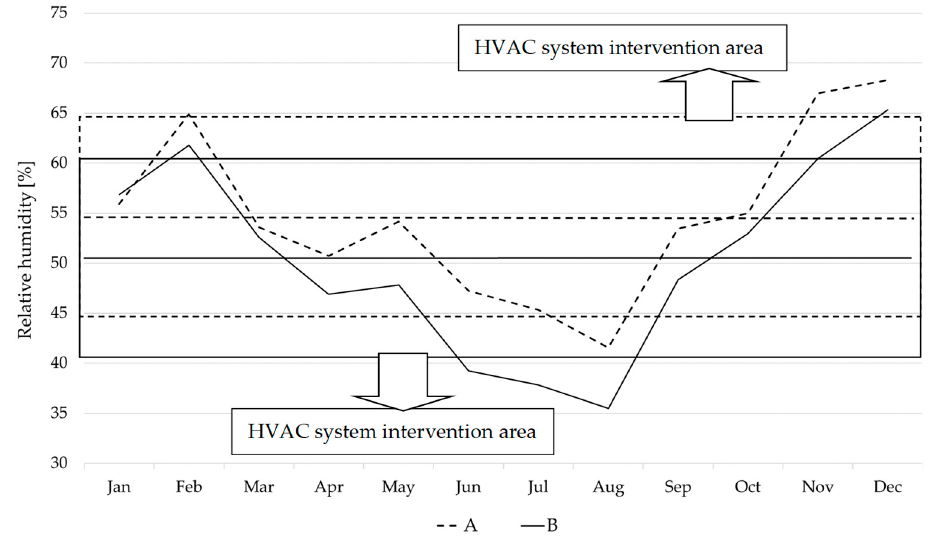
Figure 12. Trend of monthly and annual (horizontal line) mean values of RH for Lungarno ( A ) and Ponte Vecchio ( B ). The rectangles define the range of acceptable values for the two zones.